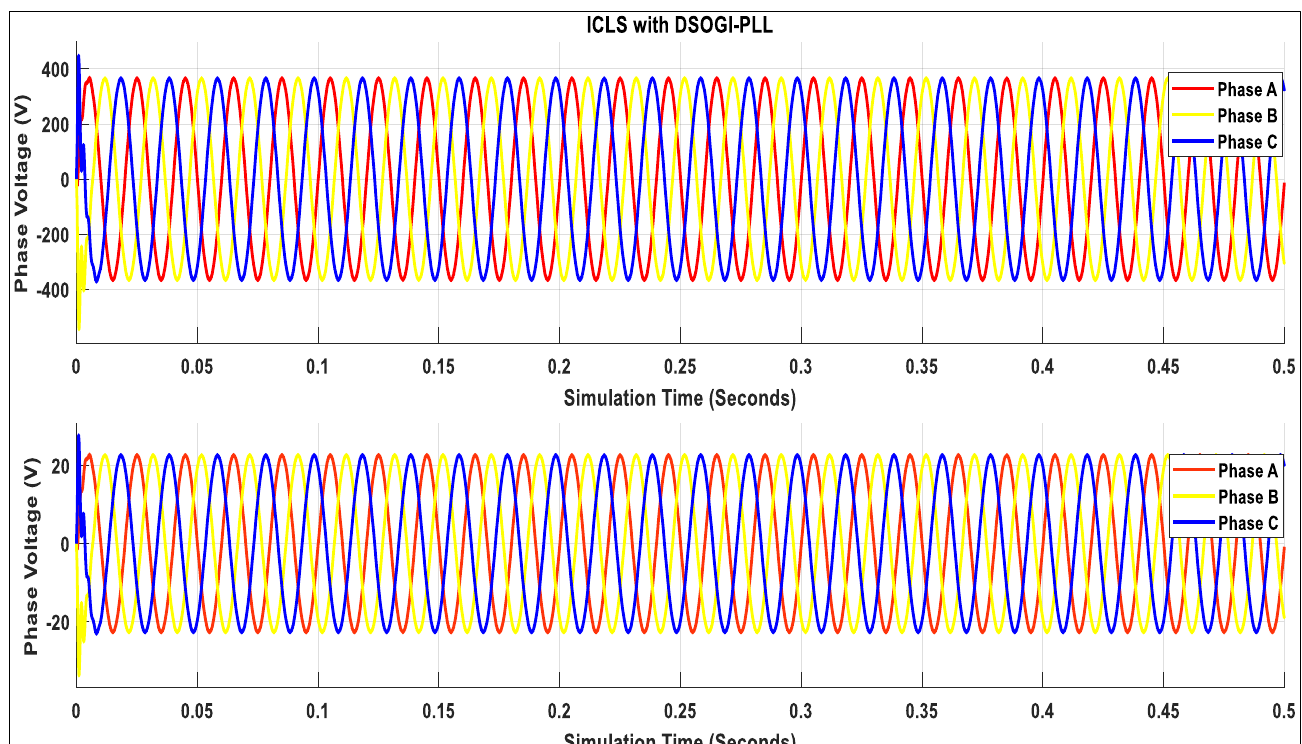
Figure 20. PSC pattern 3 FRMO-DSP MPPT results (case study 3).